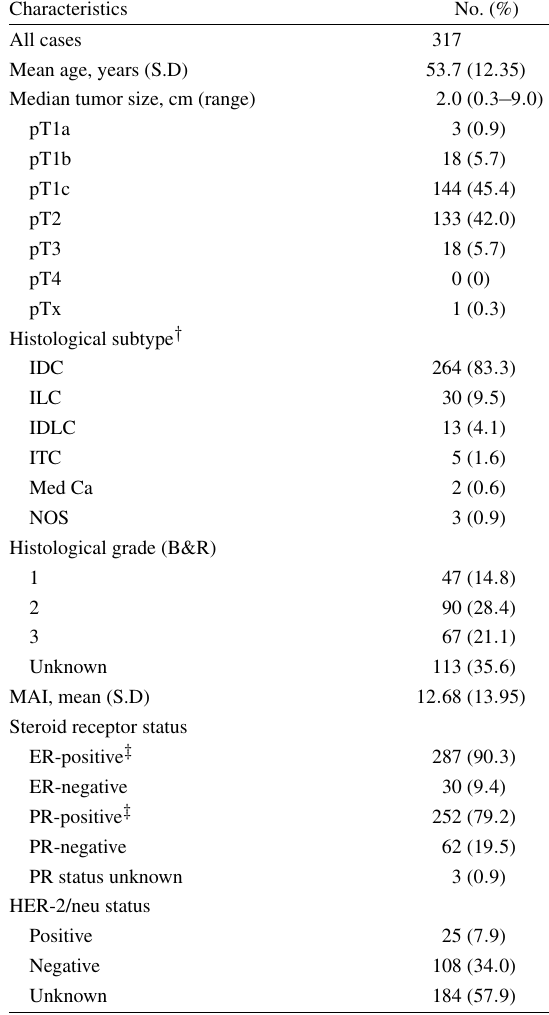
Clinicopathologic characteristics of invasive breast cancer patients with a positive SN